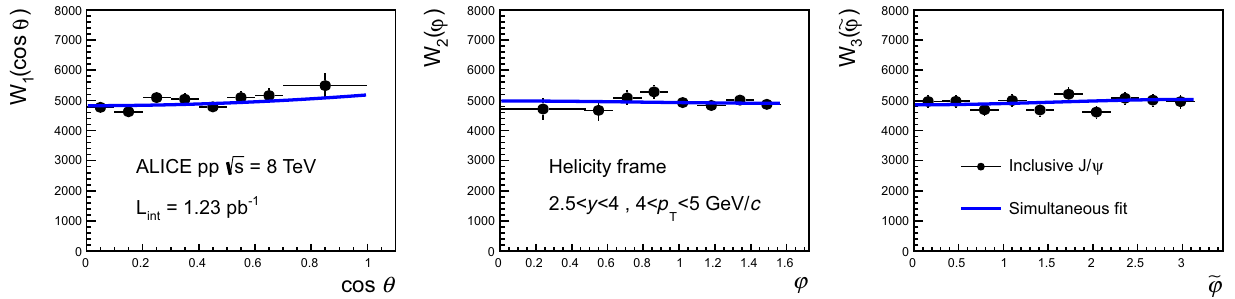
Fig. 2 AcceptancecorrectedangulardistributionsofJ/ ψ reconstructed inthedi-muondecaychannel W 1 ( cos θ) , W 2 (ϕ) and W 3 ( (cid:6) ϕ) inthehelic- ity frame for the transverse momentum interval 4 < p T < 5 GeV / c ,